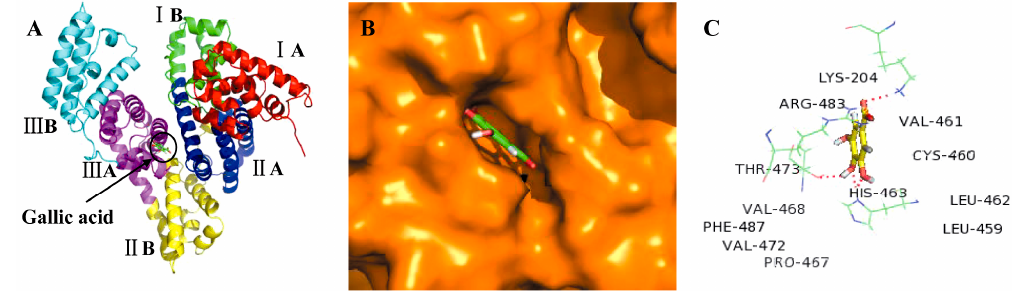
Figure 4. ( A ) The docking conformation of gallic acid-BSA complex with the lowest energy conformation; the BSA and gallic acid were represented in the cartoon as indicated; ( B ) Molecular docking model of gallic acid deeply inserted into the sub-domain IIIA of BSA; BSA and gallic acid were represented by the orange sphere model and green stick model, respectively; ( C ) The surrounding hydrophobic amino acid residues within 6 Å and hydrogen bond interactions between gallic acid and BSA; hydrogen bonds, amino acids and gallic acid were represented by red dashed lines, green lines, and yellow stick model, respectively.